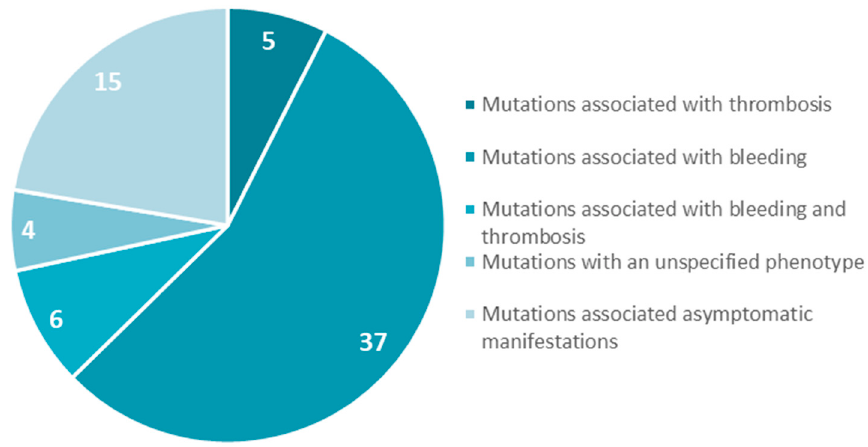
Figure 3. Mutations in exons 5–8 of the FGB gene encoded the fibrinogen B β chain.